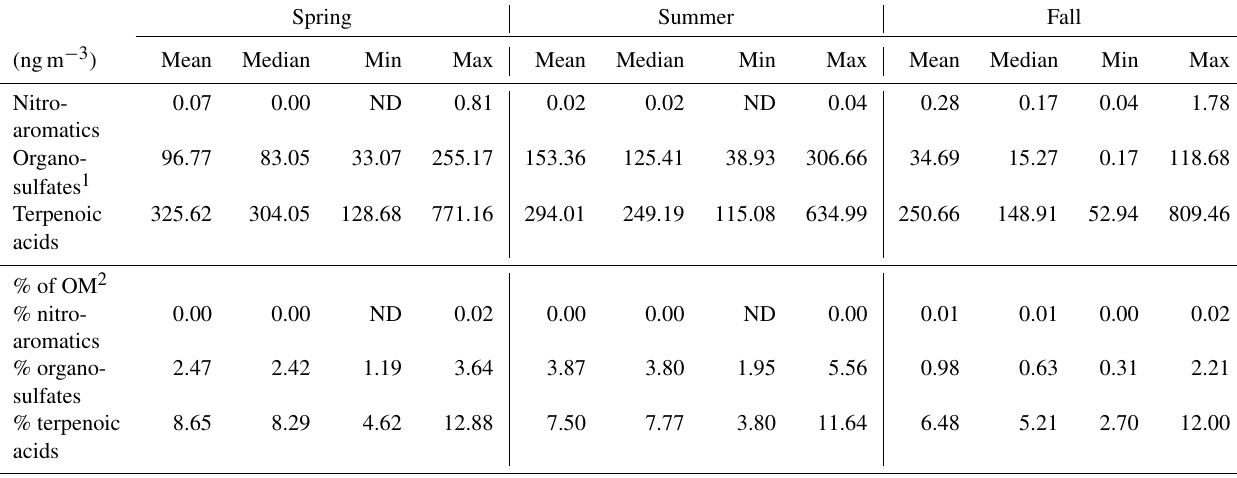
Figure 3. Time series of individual nitro-aromatic compounds and levoglucosan. Table 3. Seasonal statistics of measured groups of